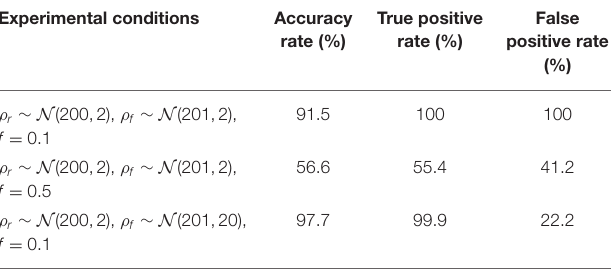
TABLE 1 | Results of unidimensional classification for three experimental conditions, with perfect observer models. Experimental